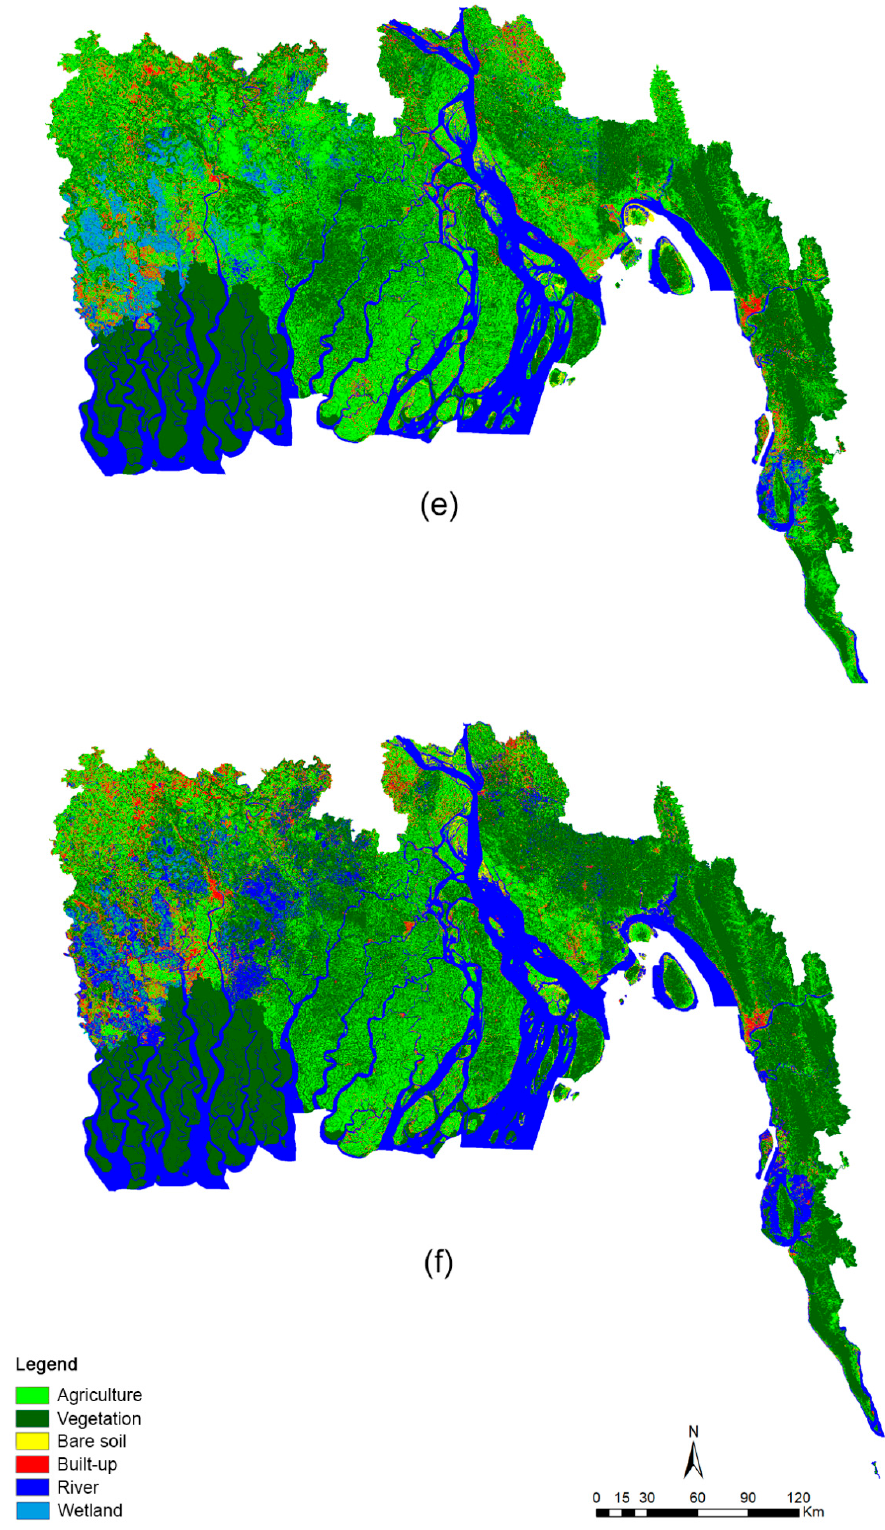
Figure 3. Classified land cover maps of the coastal area of Bangladesh: ( a ) 1990, ( b ) 1995, ( c ) 2000, ( d ) 2005, ( e ) 2010 and ( f ) Figure 3 contin. Classified land cover maps of the coastal area of Bangladesh: (e) 2010 and (f) 2017.